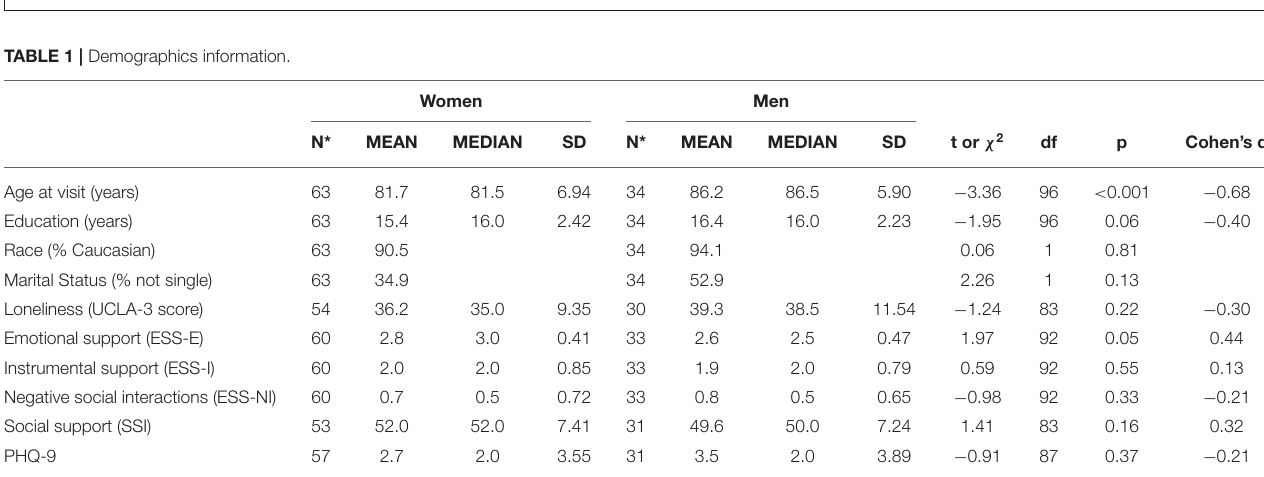
FIGURE 1 | Overview of data